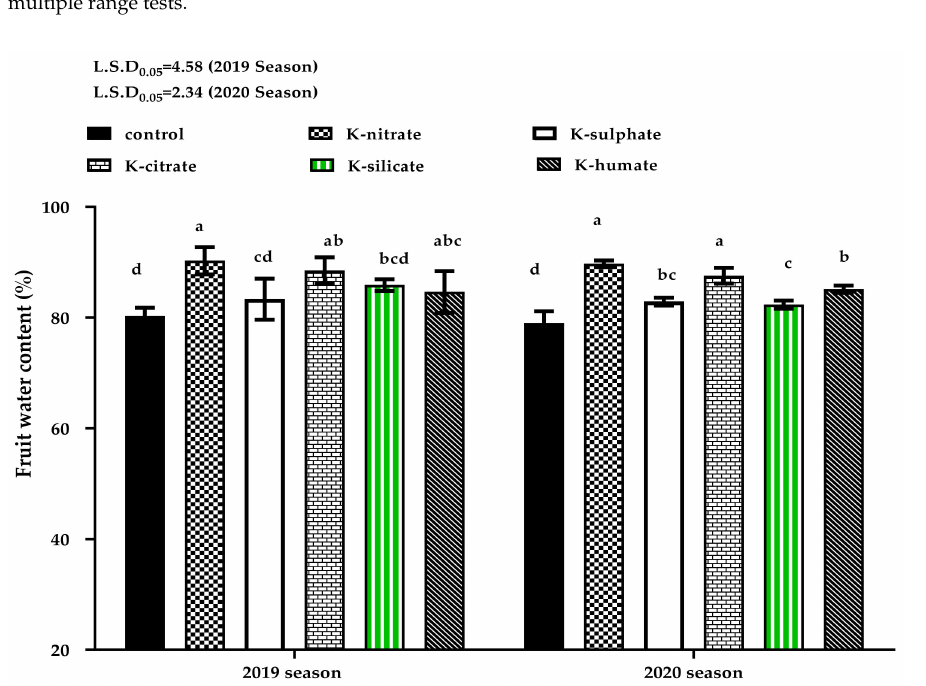
Figure 2. Effect of diverse potassium sources as foliar application on water content of ‘Canino’ apricot fruits in the 2019 and 2020 seasons. Data represent the mean with SD. Letters above each bar shown indicating significant differences among the tested treatment, if letters were same corresponding treatments are statistically equal and vice versa according to Duncan’s multiple range tests at p <